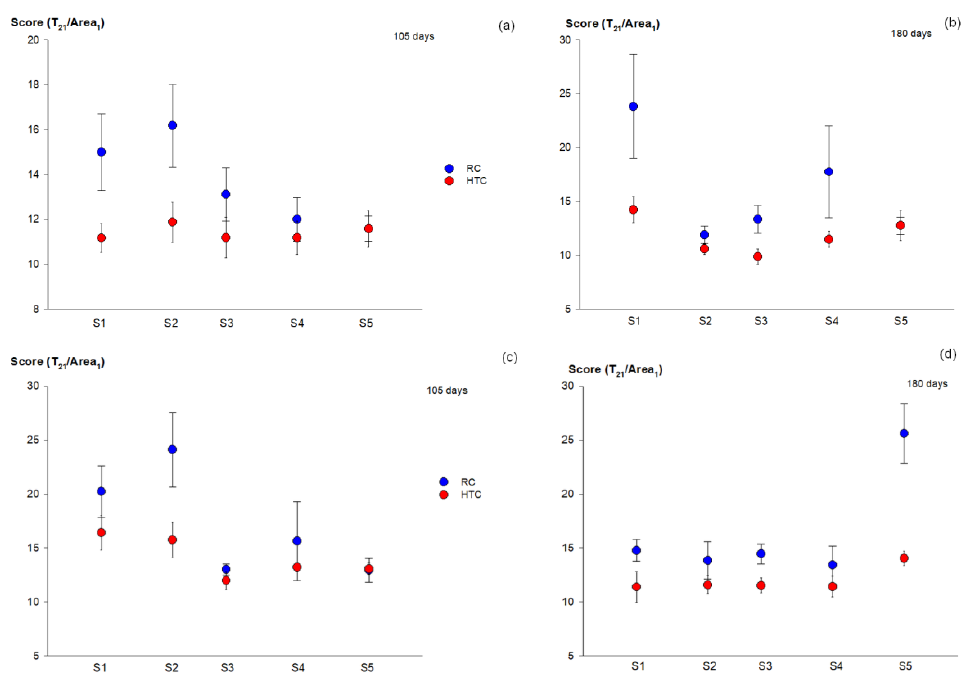
Figure 2. Score factors ( Ṩ ) of Fiore Sardo cheeses from Dataset 1: 105 days ( a ) and 180 days ( b )